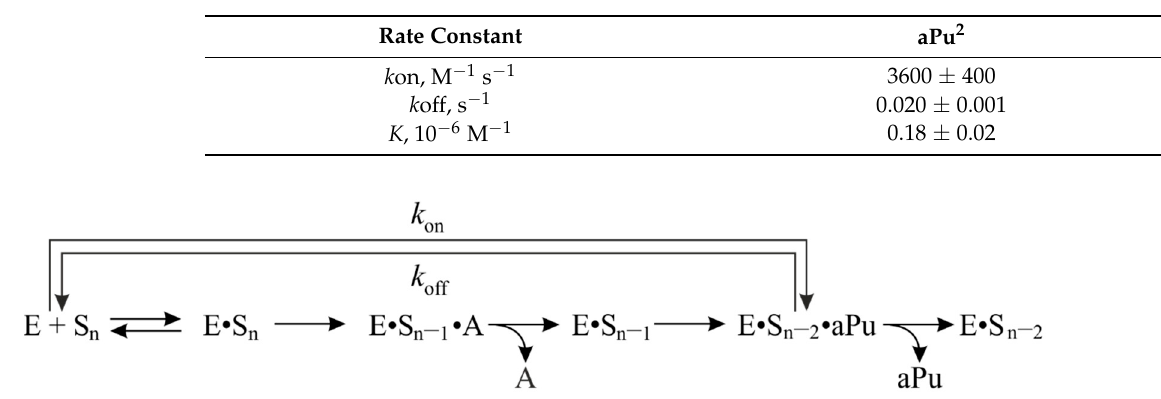
Scheme 2. The kinetic mechanism of the interaction between Nfo and substrate aPu